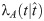
How fluctuations of the refractory density effect the population activity.(A) The conditional intensity λA(t|t^) shown as a function of t^ (left) and t (right). Typically, the conditional intensity increases as the time since the last spike grows and the neuron recovers from refractoriness. (B) For N → ∞, the population activity A(t) (hatched bin) results from λA(t|t^) averaged over the last spike times t^ with a weighting factor S(t|t^)A(t^) (blue) corresponding to the density of last spike times. Here, S(t|t^) is the survival probability. (C) The last spike times t^ are discretized into time bins. In the bin immediately before t, a large fluctuation (blue peak) was induced by forcing some of the neurons with last spike time around t* to fire. At time t, the density of last spike times (blue) has a hole and a peak of equal probability mass. The red line shows the pseudo-density S0(t|t^)A(t^) that would be obtained if we had used the survival probability S0(t|t^) of the unperturbed system. The peak at t^=t-Δt does not contribute to the activity A(t) because of refractoriness, but the hole at t^=t* contributes with a non-vanishing rate (A), implying a reduction of A(t) (hatched bin). (D) For a finite population size (here N = 400), the refractory density SN(t|t^)AN(t^) (blue), determines the expectation A¯(t) (hatched bin) of the fluctuating activity AN(t). Analogous to the forced fluctuation in (C), the finite-size fluctuations are associated with negative and positive deviations in the refractory density (holes and overshoots) compared to the non-normalized density S(t|t^)AN(t^) (red line) that would be obtained if only the mean S(t|t^) and not the exact survival fraction SN(t|t^) had been taken into account. The variance of the deviations is proportional to v(t,t^) given by Eq (12). As a function of t^, v(t,t^) shows the range of t^ where deviations are most prominent (bottom). (E, F) Given the number of neurons firing in the bin [t^,t^+Δt), Δn(t^), the fraction of neurons that survive until time t is shown for ten realizations (gray lines, one highlighted in black for clarity). The mean fraction equals the survival probability S(t|t^) (red line, top panel). The variance of the number of survived neurons at time t, v(t,t^)NΔt, is shown at the bottom (red line: semi-analytic theory, Eq (12); circles: simulation). (E) Δn(t^)=5, (F) Δn(t^)=40.